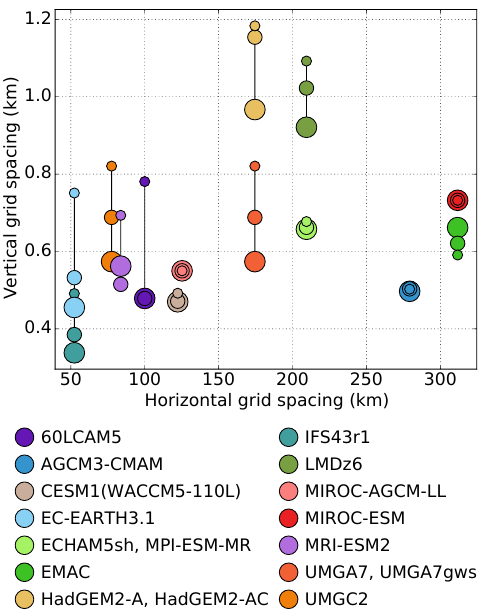
Figure 5. Vertical resolution, (cid:49)z , vs. horizontal resolution of mod- els participating in QBOi. Since (cid:49)z can vary with altitude, as shown in Fig. 4, here (cid:49)z is shown for the three layers 10–15, 15–20, and 20–25km spanning the tropical upper troposphere and lower strato- sphere, with the size of the markers scaled by the average density in each layer. See column 3 of Table 6 for the total number of ver- tical levels in each model. The horizontal grid spacing is estimated by calculating the average of the zonal and meridional grid spac- ings, ((cid:49)λ + (cid:49)φ)/ 2, and converting this to a value in kilometres at the Equator. For spectral models with triangular truncation we as- 180 ◦ /(T + 1 ) as an estimate of the transform sume (cid:49)λ = (cid:49)φ = 2 3 grid resolution, where T is the truncation wavenumber as given in column 2 of Table